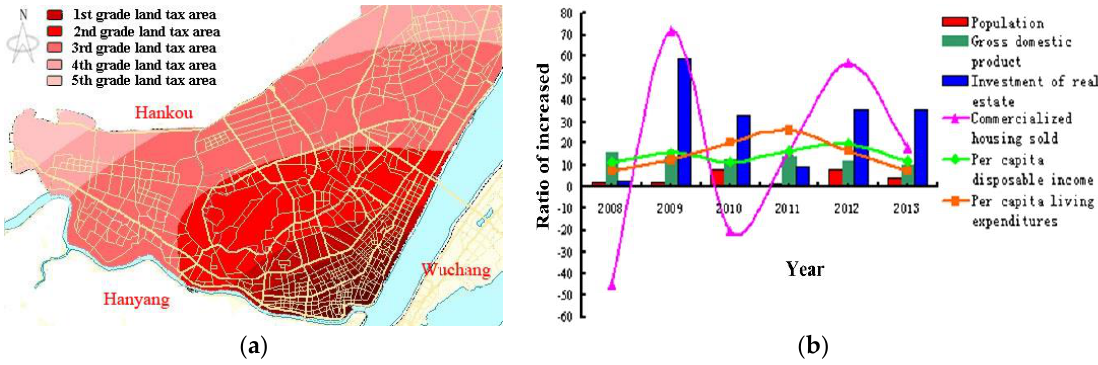
Figure 6. ( a ) Land price grade distribution map of the study area; ( b ) changes in the population growth, economic investment and development of the study area (for clarity, the numerical value of the population increase ratio is incremented 10 times; source: Wuhan statistical yearbook).